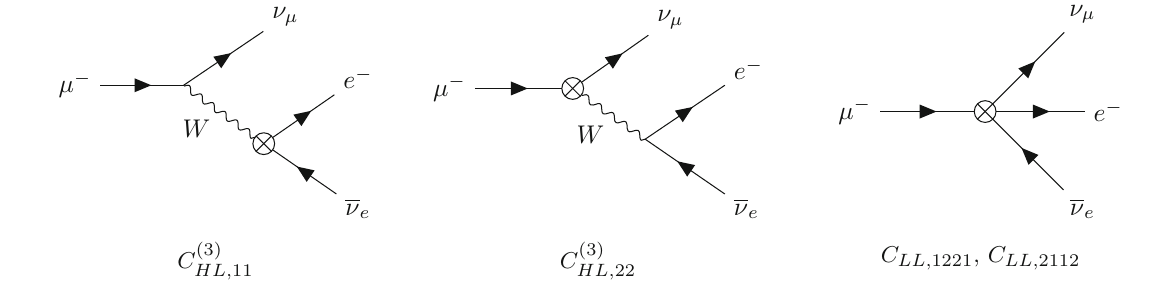
Fig. 8 Muon decay diagrams with the effective operators contributing to δ ˆ G F , given in Eq. (5)